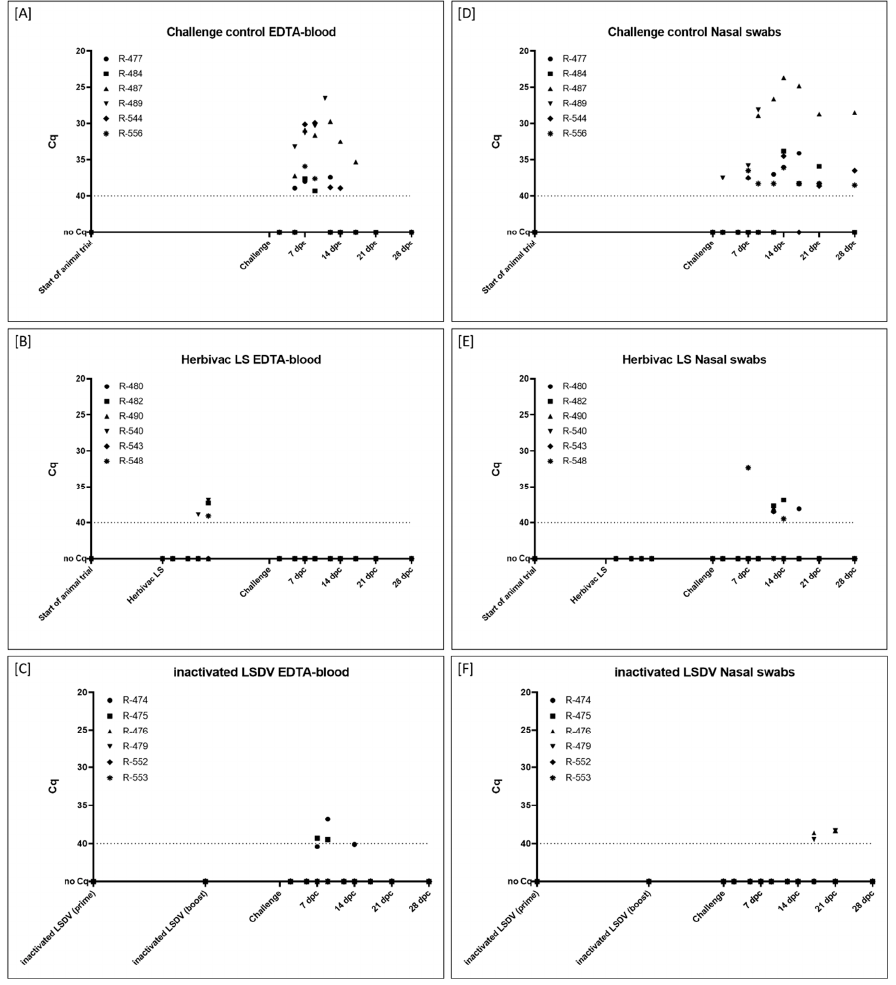
Figure 5. Viral genome load in ( A – C ) EDTA-blood and ( D – F ) nasal swab samples taken during the proof-of-concept study. ( A + D ) Cattle of Group 1A were left unvaccinated and served as challenge control group. ( B + E ) Cattle of Group 1B received the commercially available life-attenuated vaccine “Herbivac LS”, and ( C + F) cattle of Group 1C were vaccinated with an inactivated vaccine prototype on basis of LSDV-“Neethling vaccine” strain. Samples were taken at defined time points during the animal trial and analyzed regarding their viral genome load. Cut-off was defined at Cq 40.0.